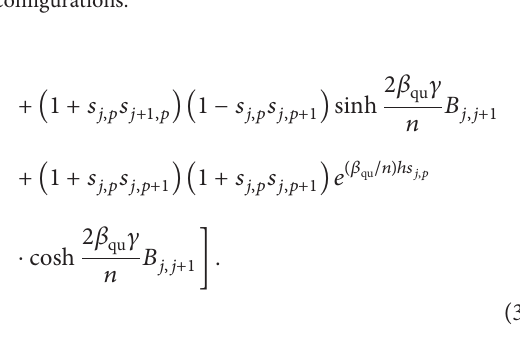
Figure 3: The 8 allowed vertex